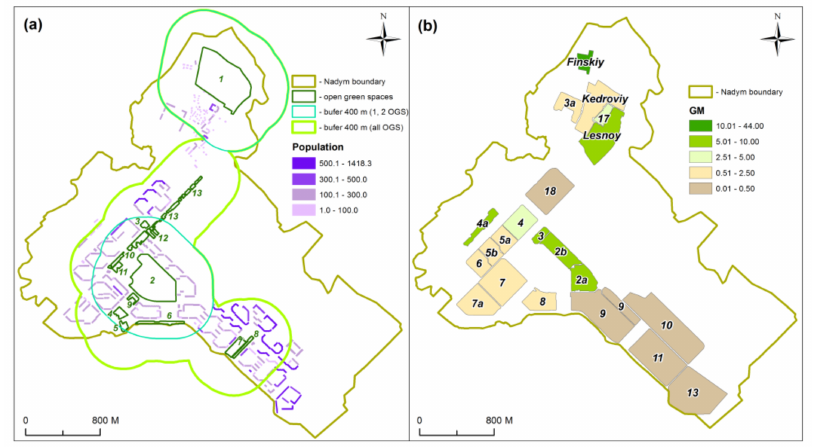
Figure 7. Accessibility of open green spaces ( a ) and “greenness” (provision of vegetation) by mi- crodistricts ( b ) of Nadym.